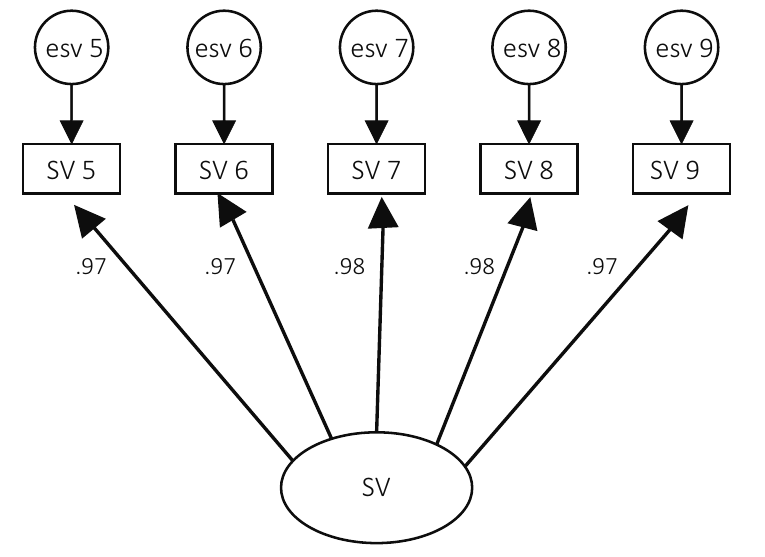
Figure 3. Path diagram of social value